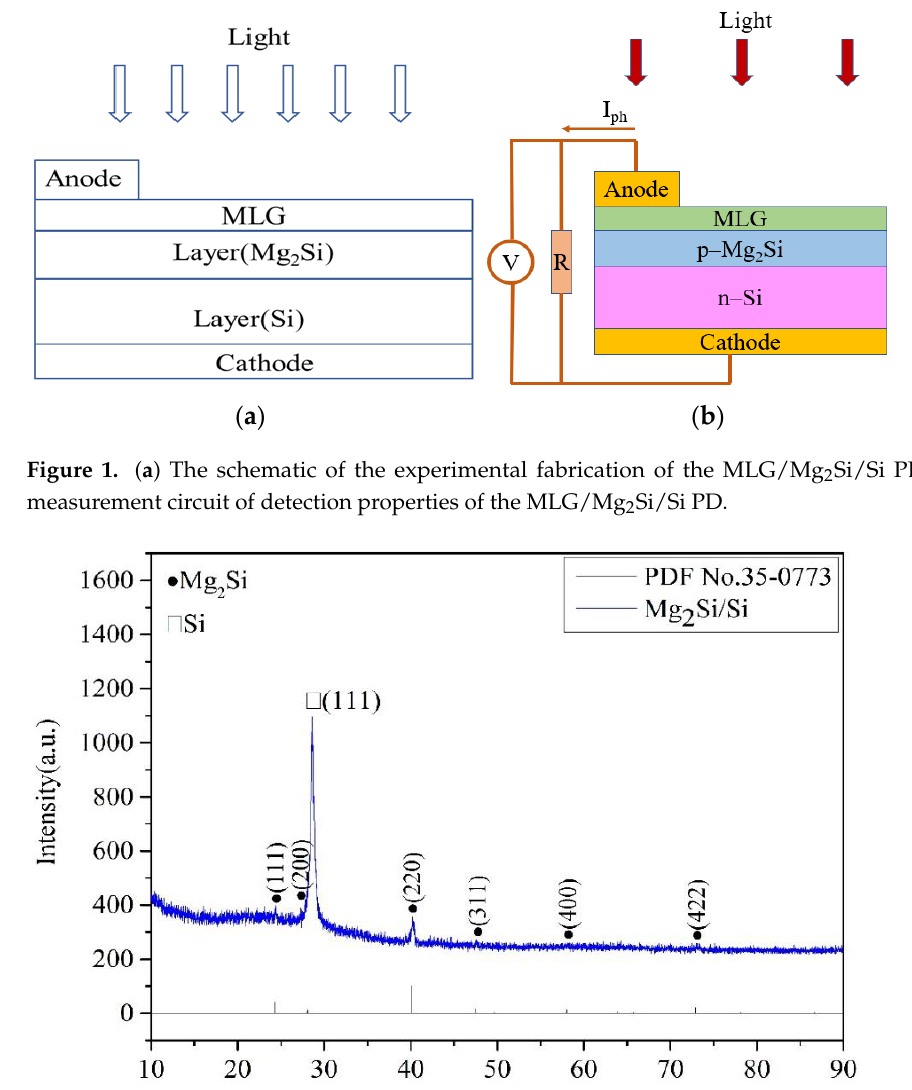
Figure 1. ( a ) The schematic of the experimental fabrication of the MLG/Mg 2 Si/Si PD; ( b ) the meas- urement circuit of detection properties of the MLG/Mg 2 Si/Si PD.